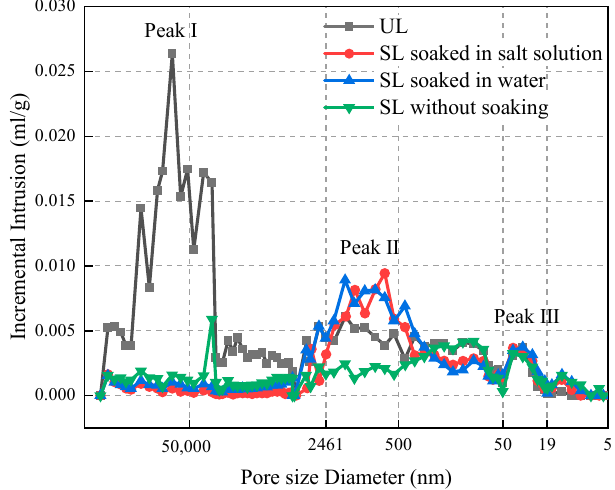
Figure 14. Incremental intrusion.